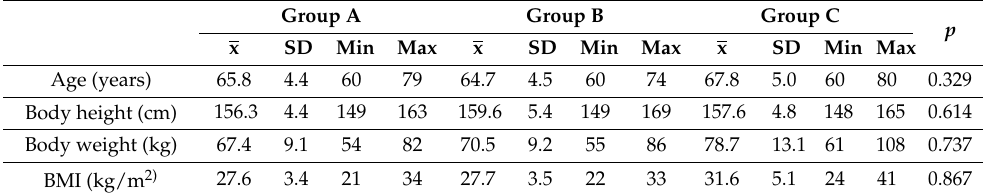
Table 1. Morphological characteristics of the studied